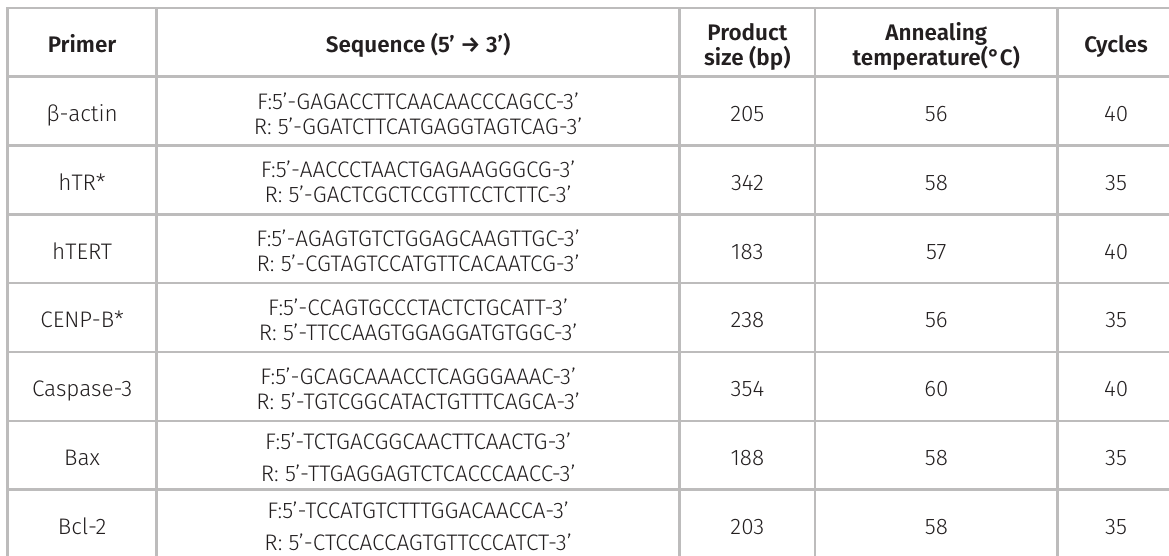
Table I. PCR Primers sequence and